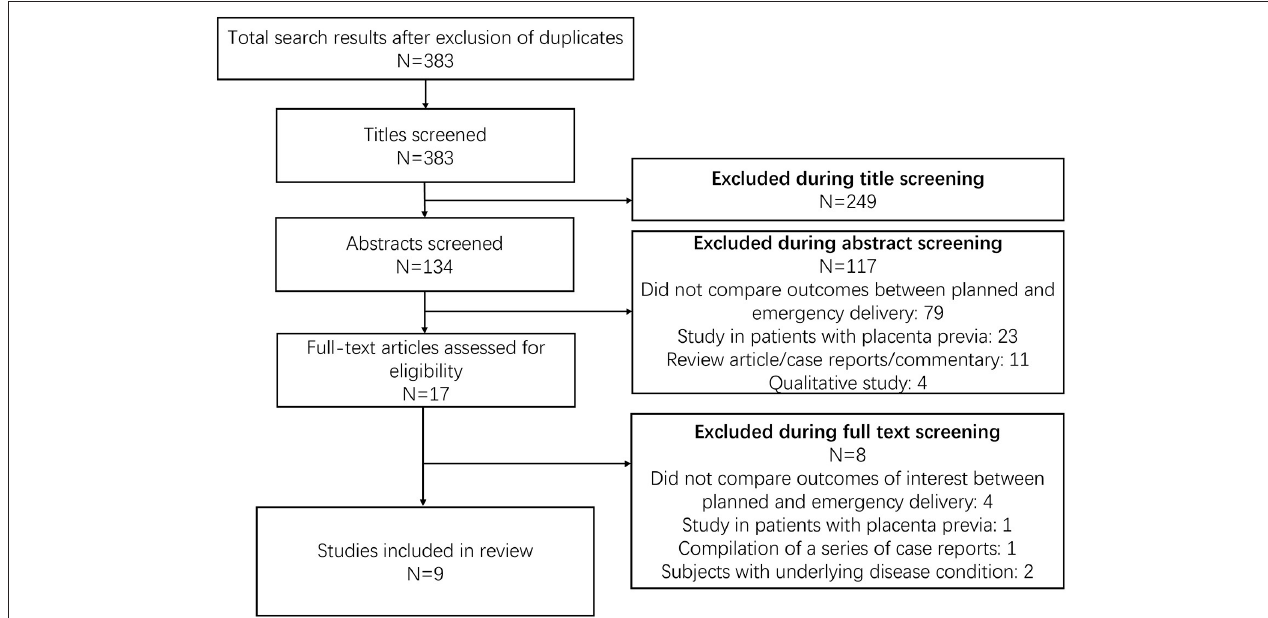
FIGURE 1 | Study screening